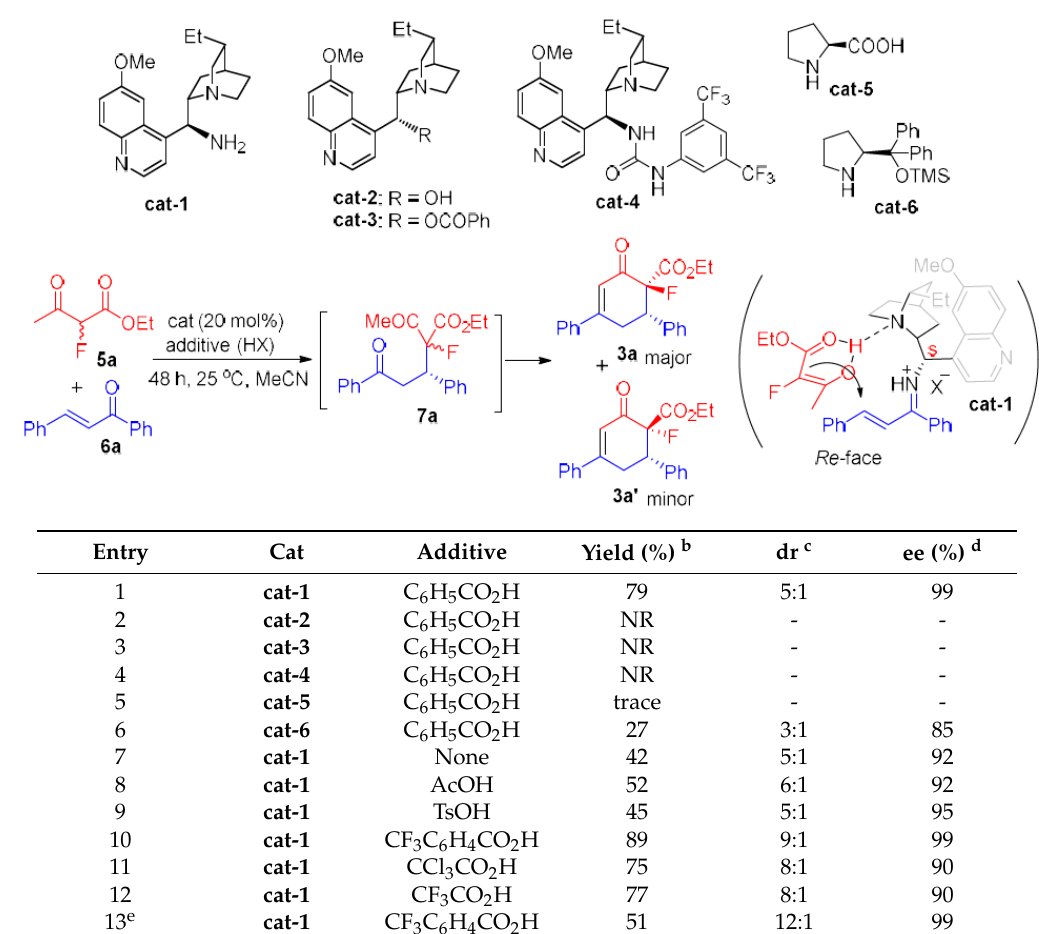
Table 1. Screening of catalysts for the Robinson annulation a .